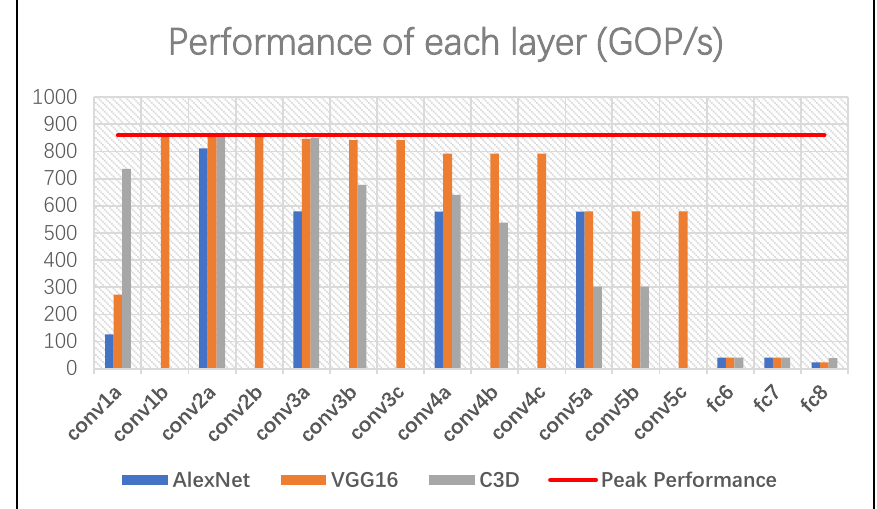
Figure 8. Throughput performance of each layer in three CNN models.